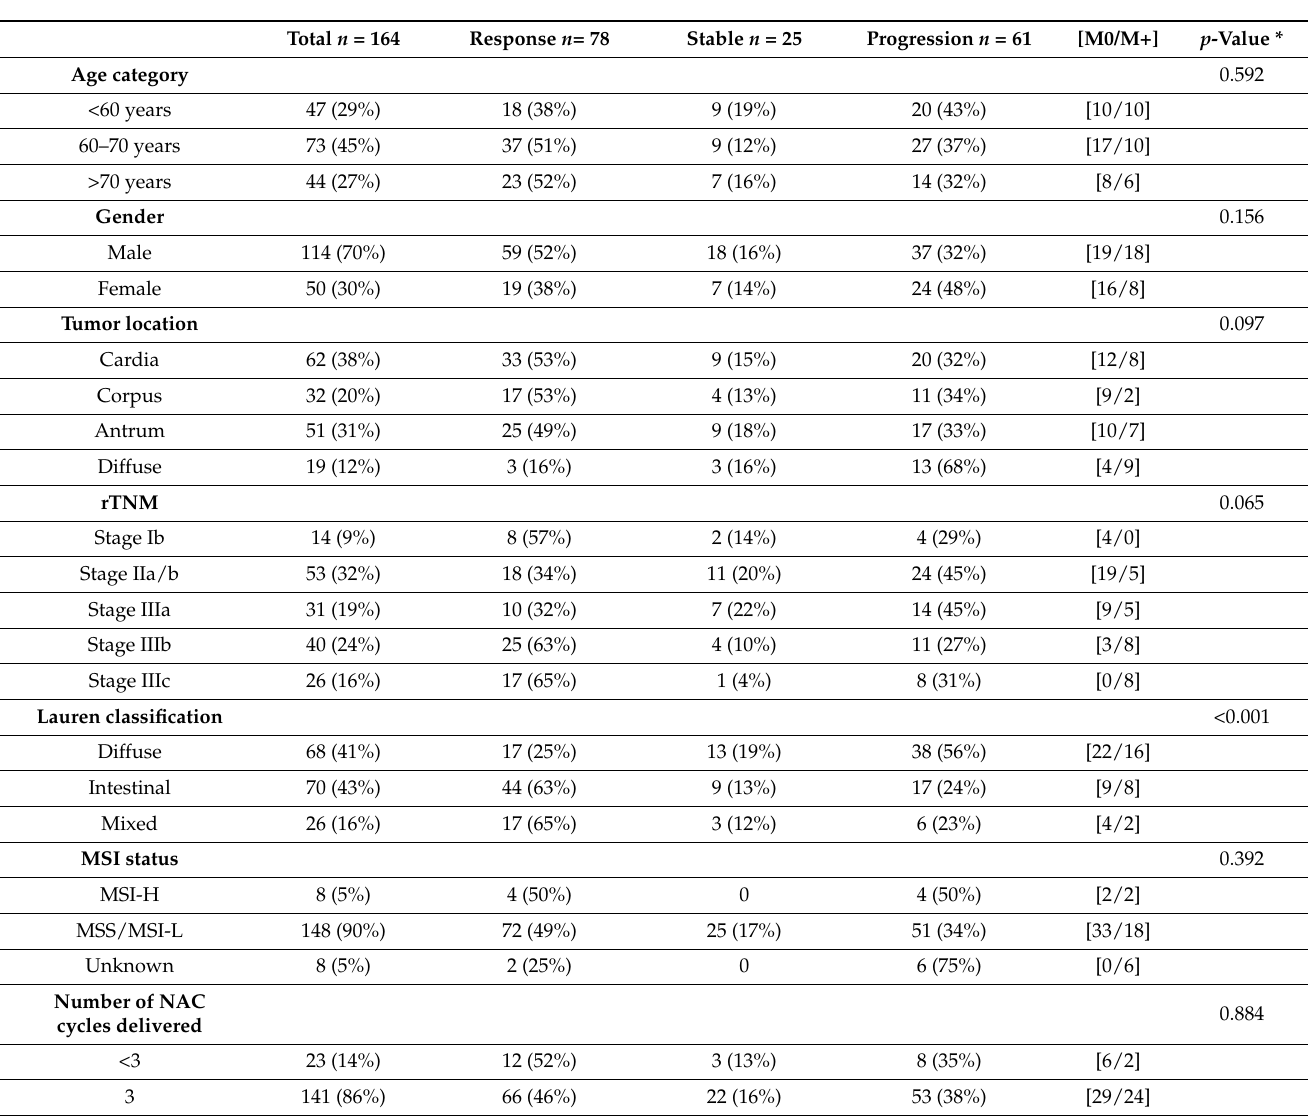
Table 1. Clinical variables for patients with resectable gastric cancer in 2007–2016 receiving neoadju- vant chemotherapy and available for TNM response evaluation, cross-tabulated with the response mode ( n =